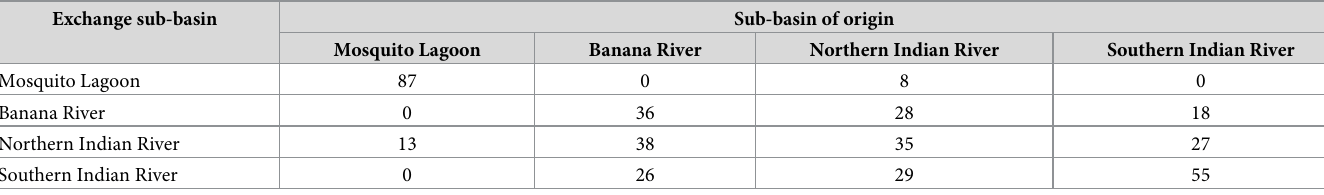
Table 2. Percentage of marked bottlenose dolphins exchanged among four Indian River Lagoon sub-basins. Exchange